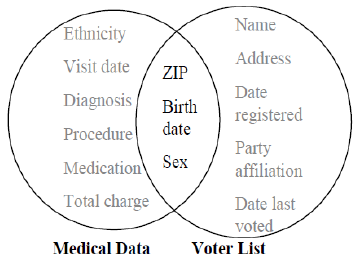
Figure 1. Linking to reveal sensitive information [1] .